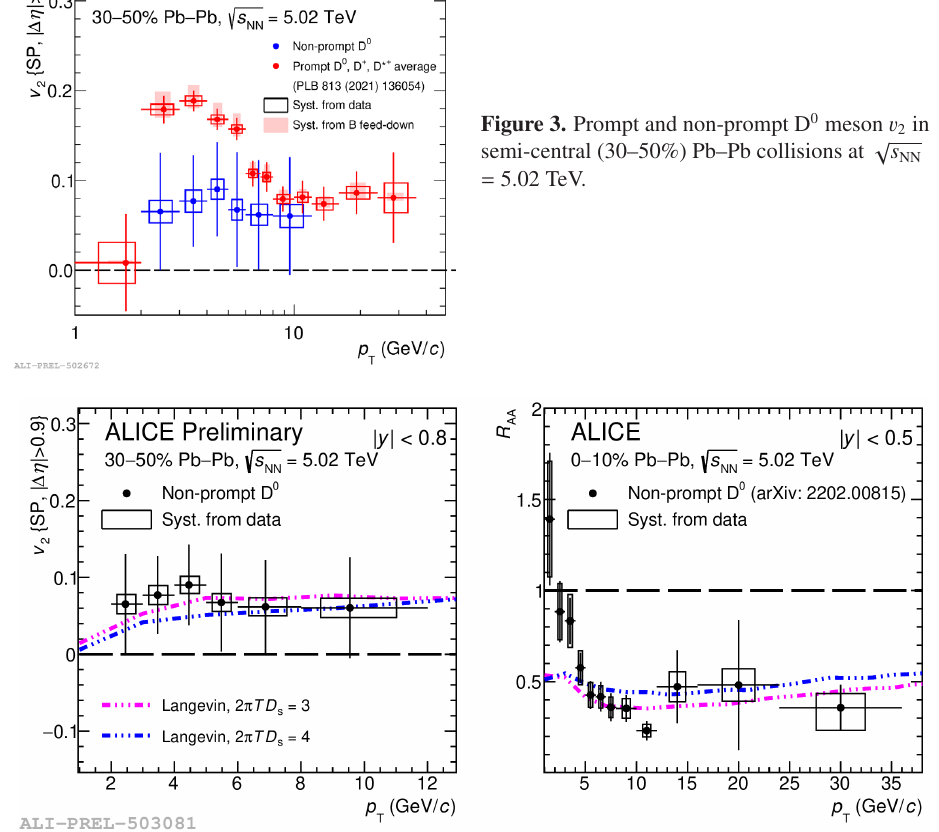
Figure 4. Non-prompt D 0 meson v 2 (left) and R AA (right) in central and semi-central Pb–Pb collisions at √ s NN = 5.02 TeV, respectively. The results are compared with theoretical predictions based on Langevin calculations that adopt di ff erent values for the di ff usion coe ffi cient